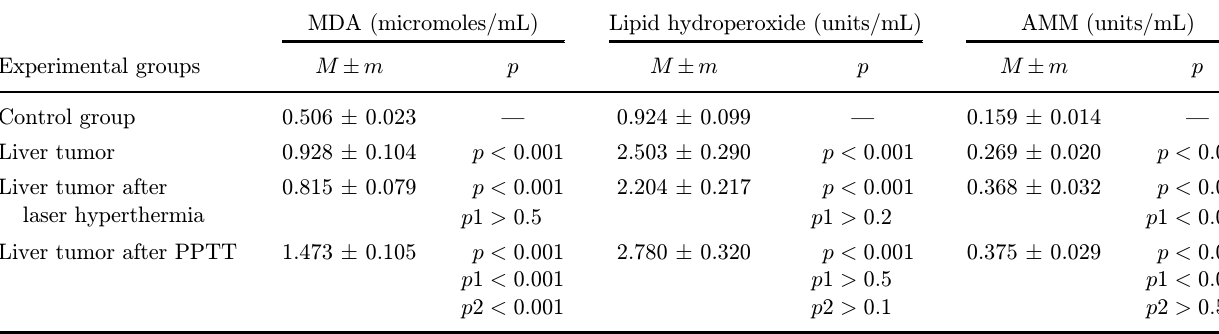
Table 1. Indicators of lipid peroxidation and autointoxication of rats.